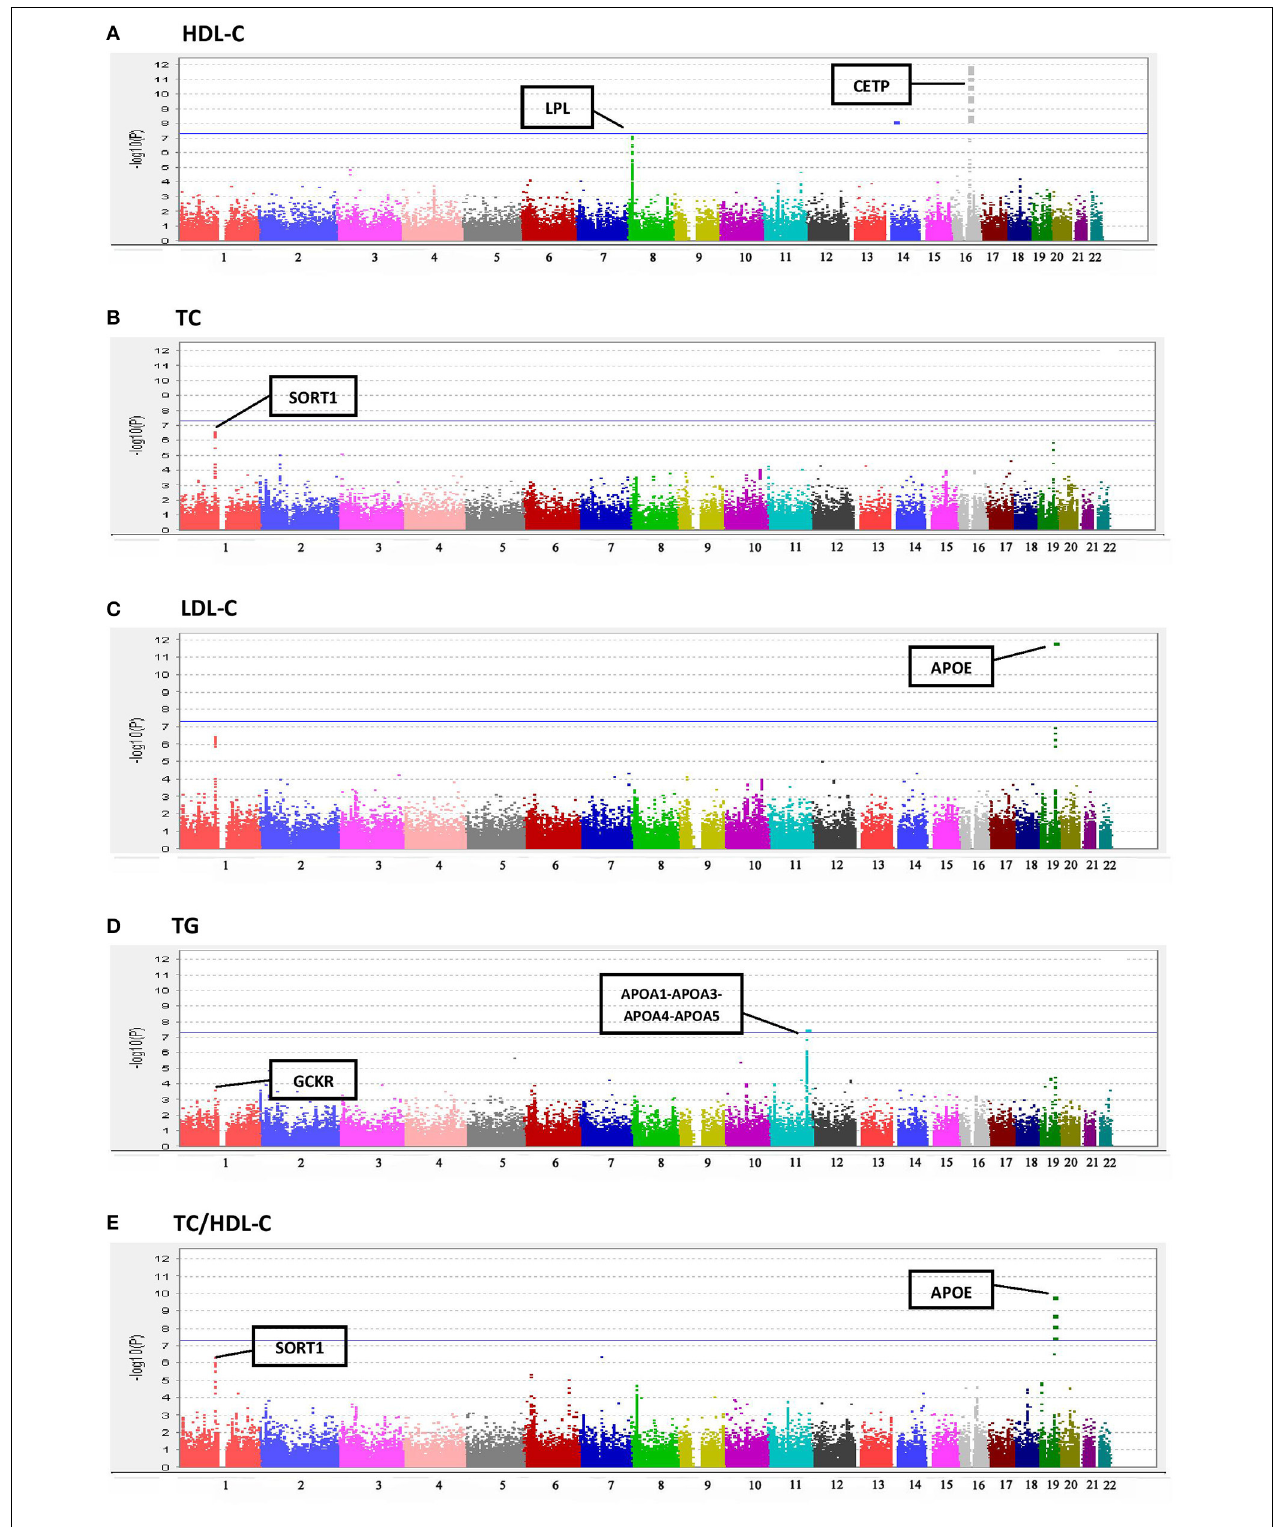
FIGURE 1 | Manhattan plots for associations of TC, HDL-C, LDL-C, TG, and TC/HDL-C with 190,446 SNPS from the Metabochip. (A) HDL-C. (B) TC. (C) LDL-C. (D) TG. (E) TC/HDL-C.